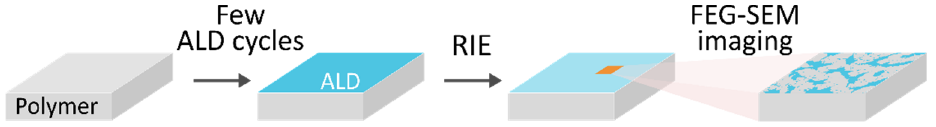
Figure 1. Schematic representation of the approach to visualize the ALD nucleation on polymers.